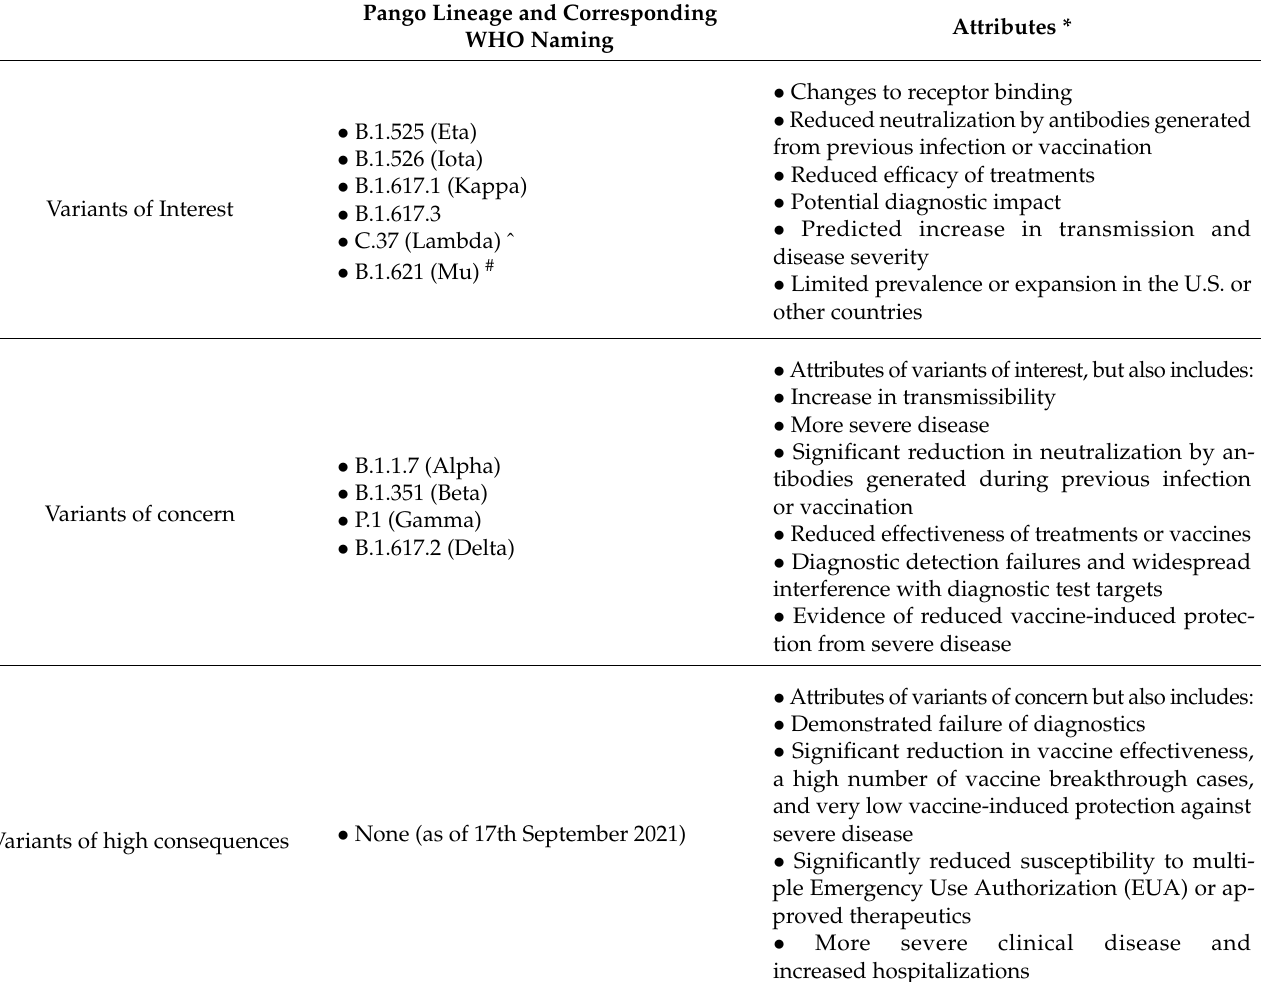
Table 1. Classification of SARS-CoV-2